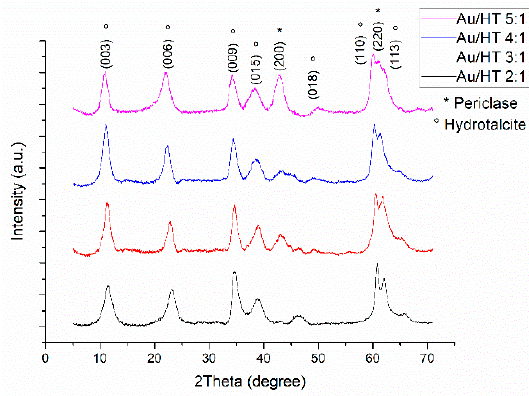
Figure 2. Au / HTs catalysts X-ray di ff ractograms. Figure 2. Au/HTs catalysts X-Ray diffractograms. Figure 2. Au/HTs catalysts X-Ray diffractograms.